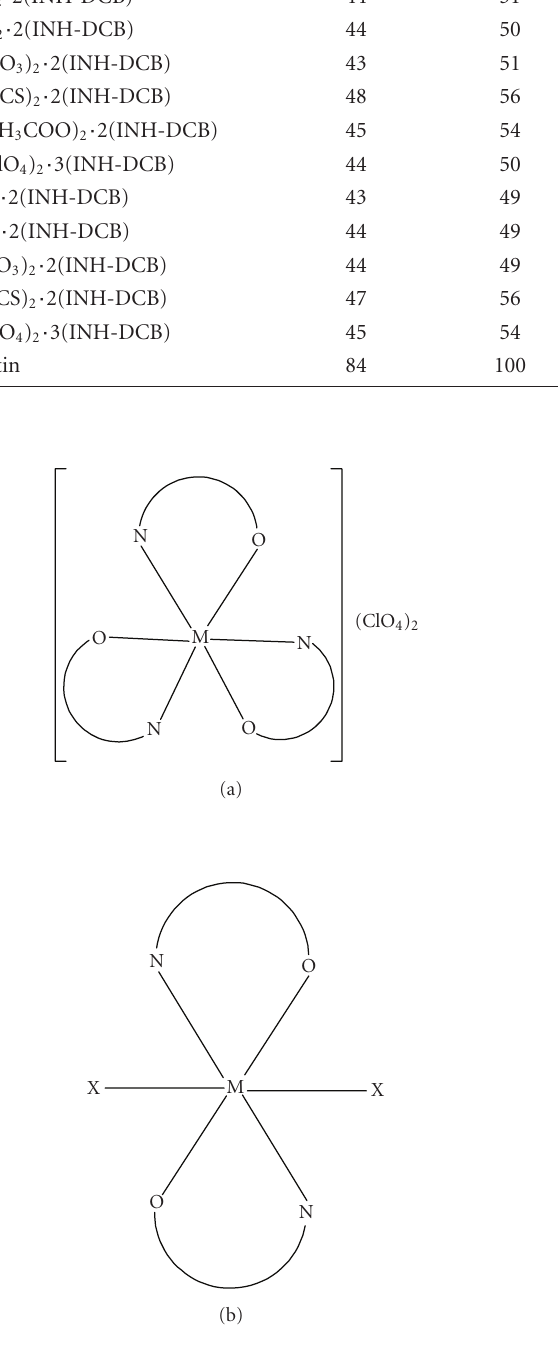
Figure 2: (a) Suggested structure of [M(INH-DCB) 3 ] (ClO 4 ) 2 (M = Co 2+ or Ni 2+ ); (b) suggested structure of [M(INH-DCB) = Co 2+ or Ni 2+ ; X = Cl − , Br − , I − , NCS − , or NO